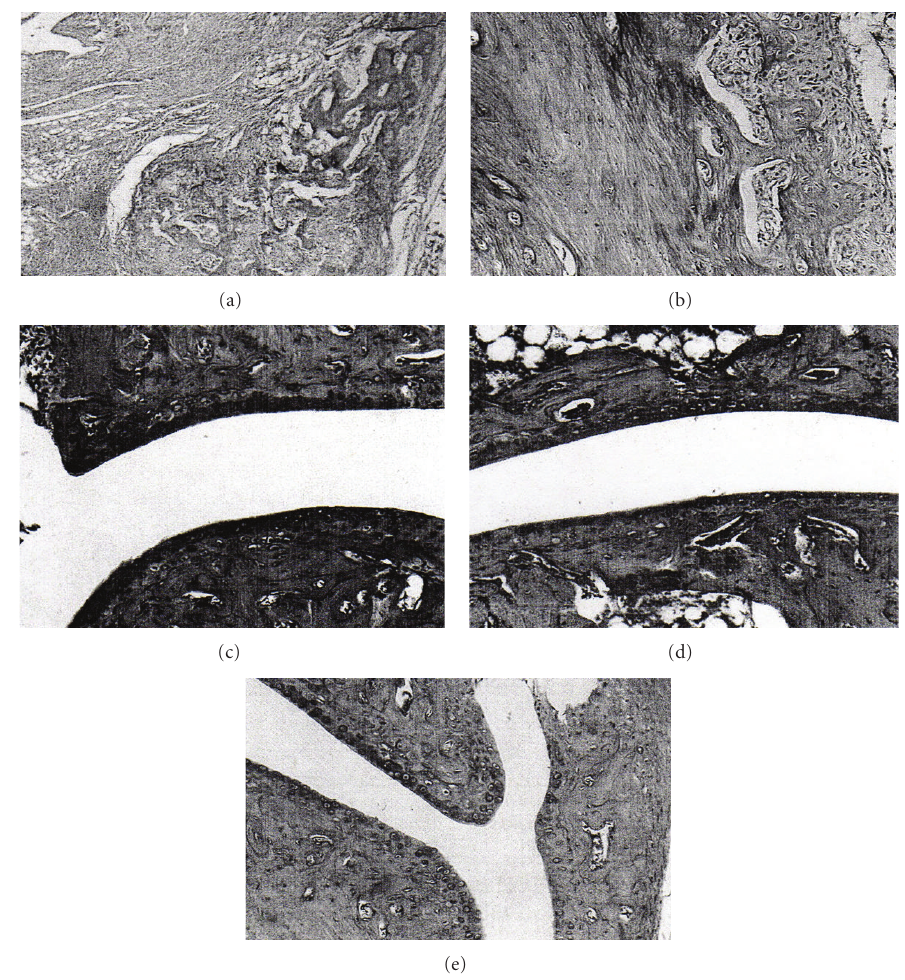
Figure 2: Histopathological responses detected in irradiated ((a) and (b)) and nonirradiated ((c) and (d)) C3H/HeJ mice injected with B. burgdorferi sensu stricto isolate 297. Irradiated control mice (e) were injected with BSK medium. All specimens were acquired 21 days after challenge, with the exception of panel (c), day 14. Panels (a) and (b) were viewed with a 4x or 10x objective lens,